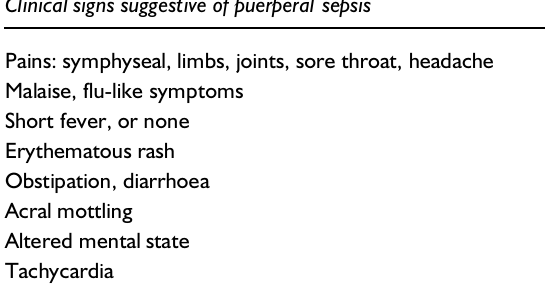
Table 3 Early clinical signs suggesting puerperal sepsis